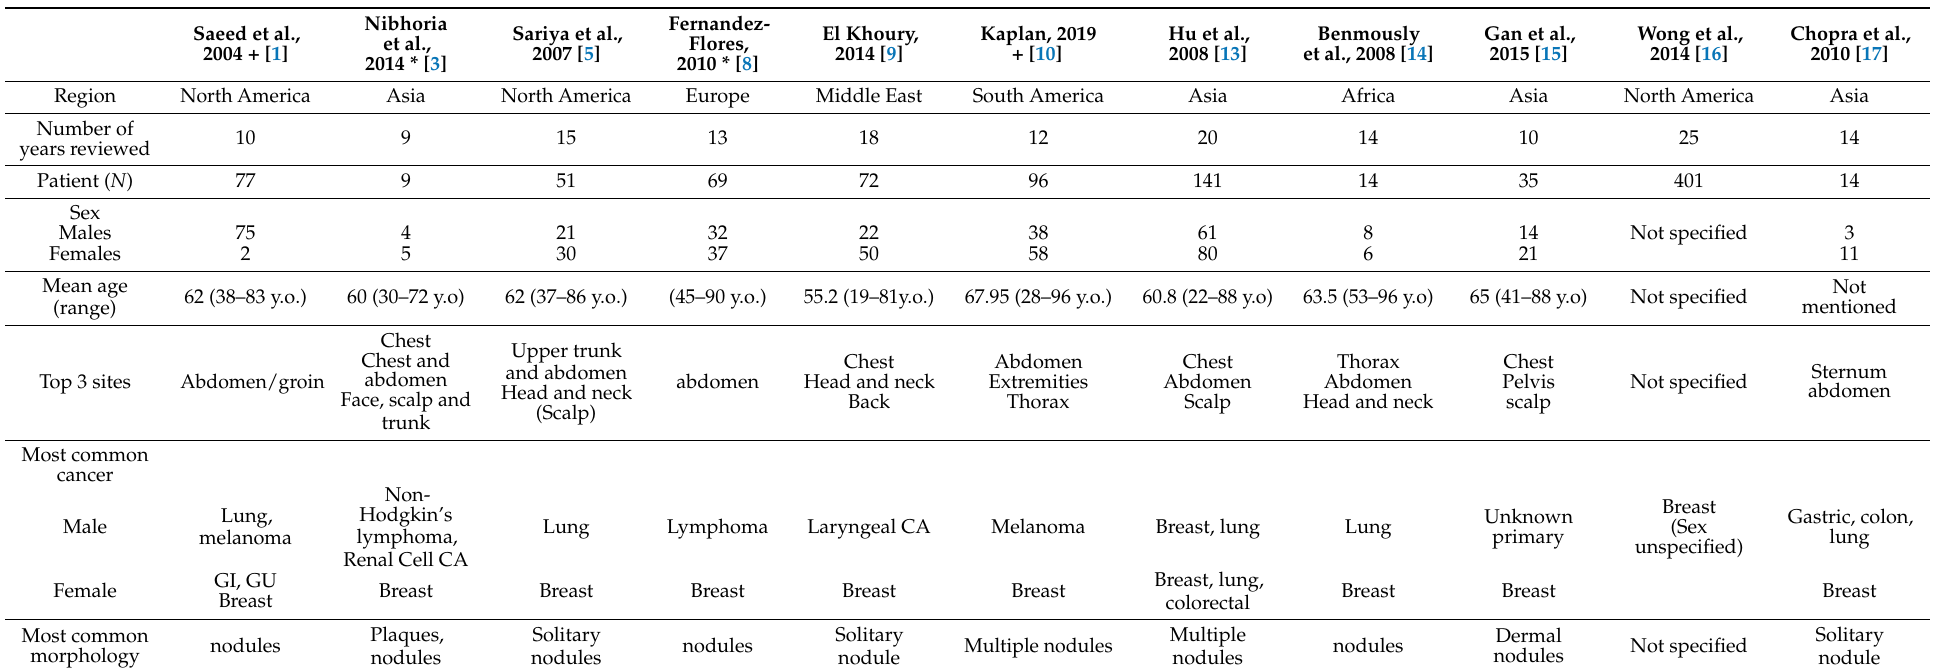
Table 6. Summary table for different retrospective studies on cutaneous